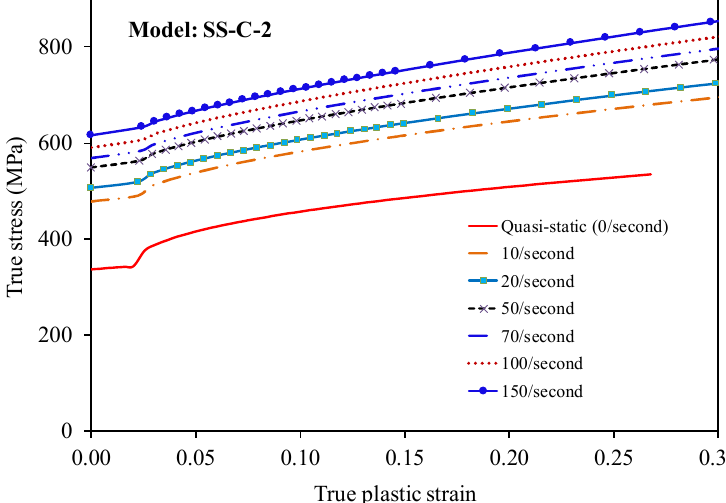
Figure 2. True stress-strain curve applied in FE analysis for RS-C-3 model.